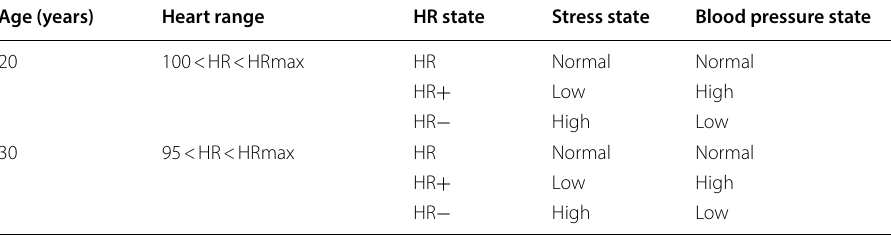
Table 3 Description of heart rate, stress and blood pressure values